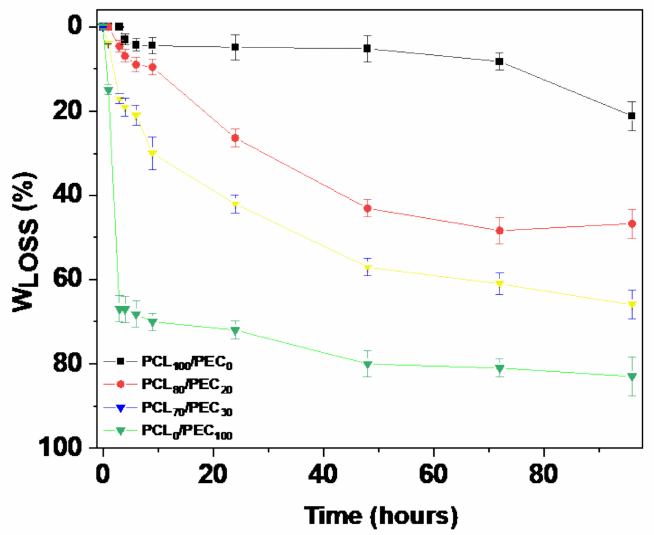
Figure 5. Weight loss (%) of of neat polymers PCL and PEC and the corresponding blends as a function of time immersed in 1M NaOH solution in the hydrolytic degradation study.